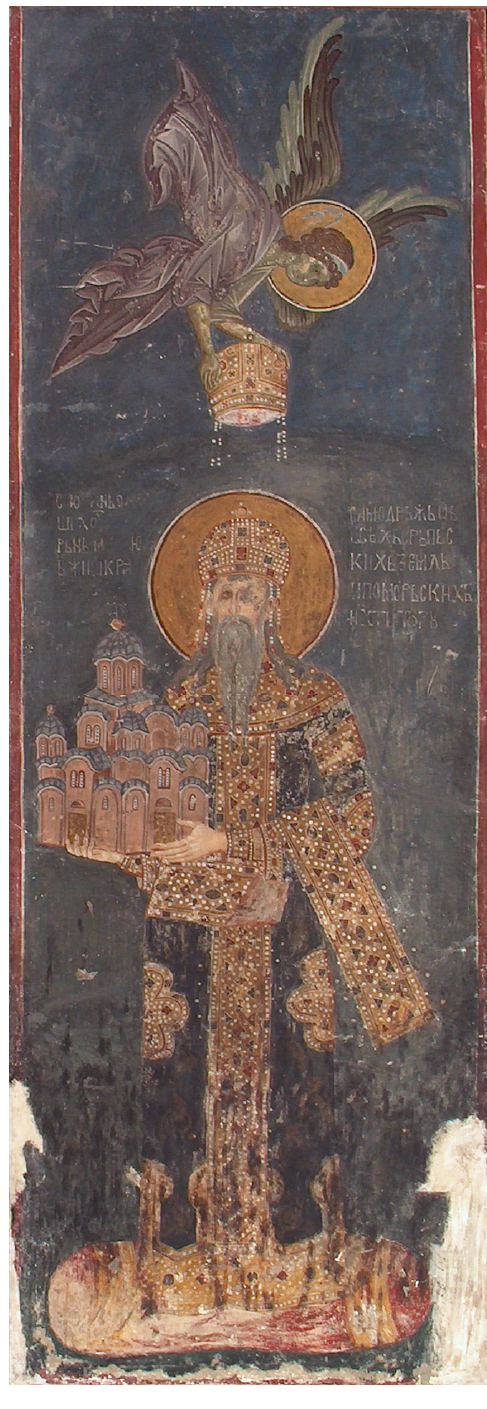
Figure 5. King Milutin with the church, fresco, 1321. Church of Annunciation, Monastery of Graˇcanica, northern part of the vault between the narthex and nave. Courtesy Gallery of Frescoes,